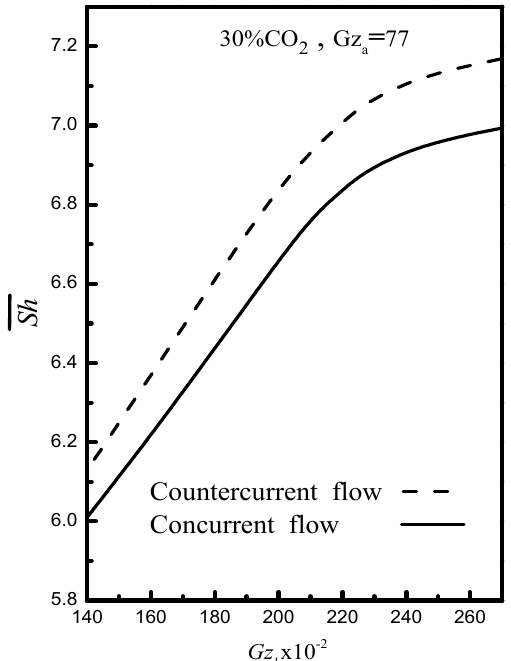
tion rate in considering the mass transfer behavior. The theoretical prediction Sh which varies with the mass-transfer Graetz number of the absorbent solution (absorbent flow rates Q b ) for both concurrent- and countercurrent-flow operations is presented in Figure 7, where the averaged mass-transfer Sherwood number Sh in countercurrent-flow operations is higher than that in concurrent-flow operations. This result confirms that the higher mass transfer coefficient is obtained in countercurrent-flow operations that come up with a higher absorption rate due to lower outlet CO 2 concentrations, as demonstrated in Figure 6. It’s reasonable to conclude that the mass transfer rate represented by Sh increases in a linear relationship the smaller the mass-transfer Graetz number of the absorbent solution.